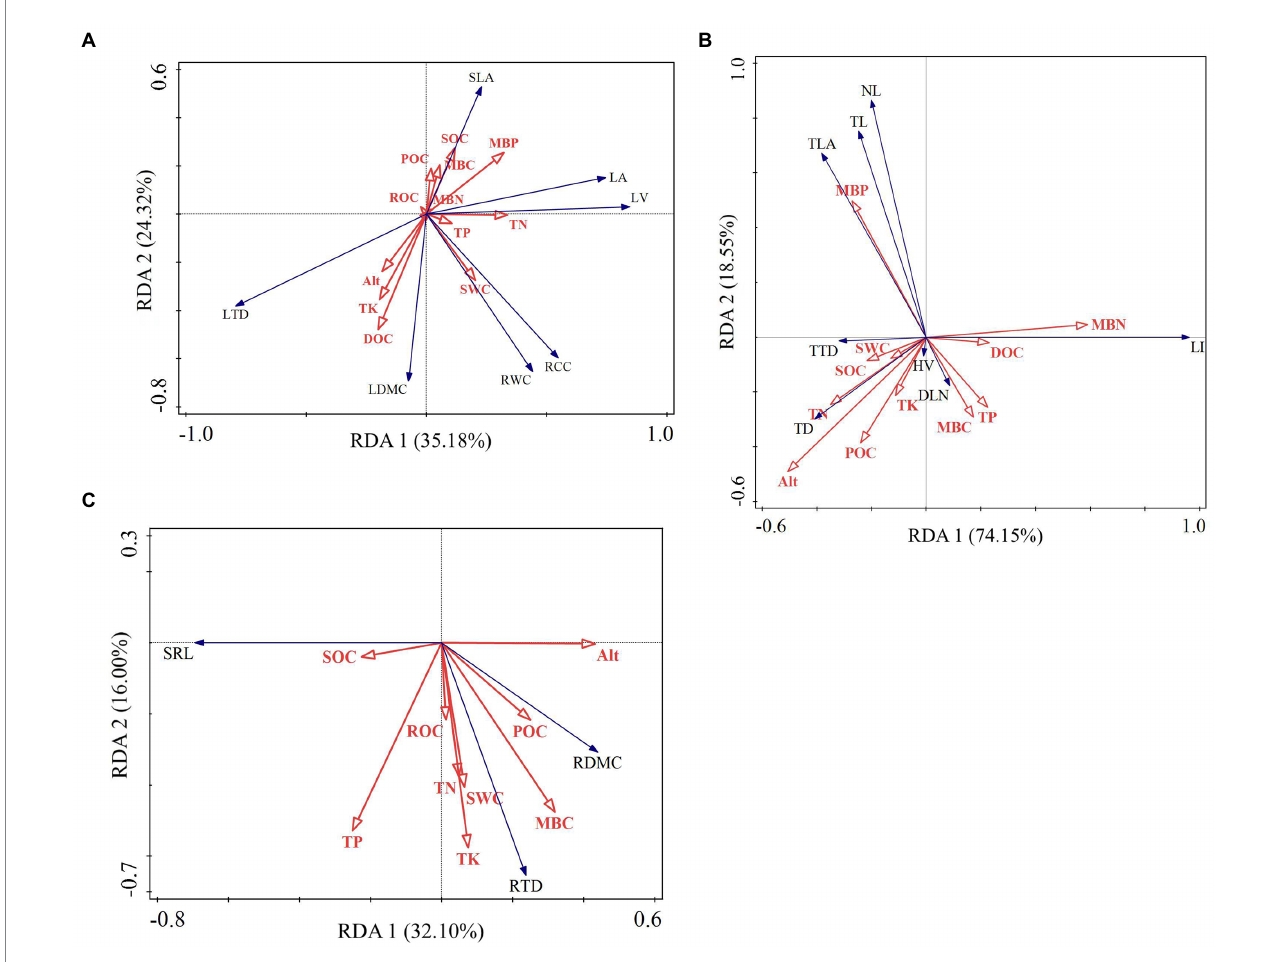
FIGURE 8 Redundancy analysis of the association of environmental factors with functional traits of leaf (A) , current-year twig (B) , and fine roots (C) .